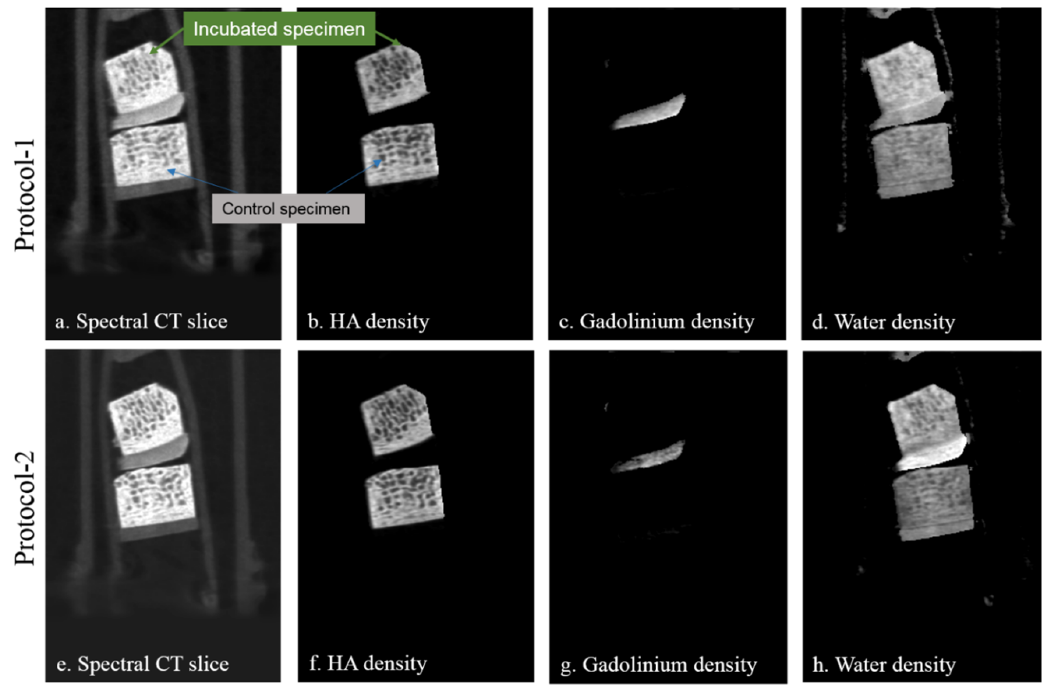
Figure 13. A single energy spectral CT image of two bovine knee plugs and material component images for hydroxyapatite, gadolinium, and water obtained from the material decomposition with protocol-1 ( top row ) and protocol-2 ( bottom row ). The window levels are normalized from 0 to 1 for display.